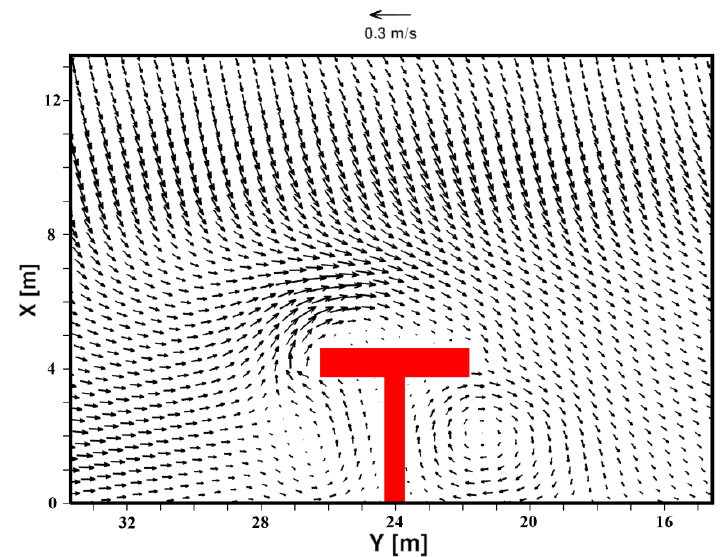
Figure 8. Plan view of the time-averaged velocity field. Near the free surface, at a relative position from the free surface z / z b = 0.133 .